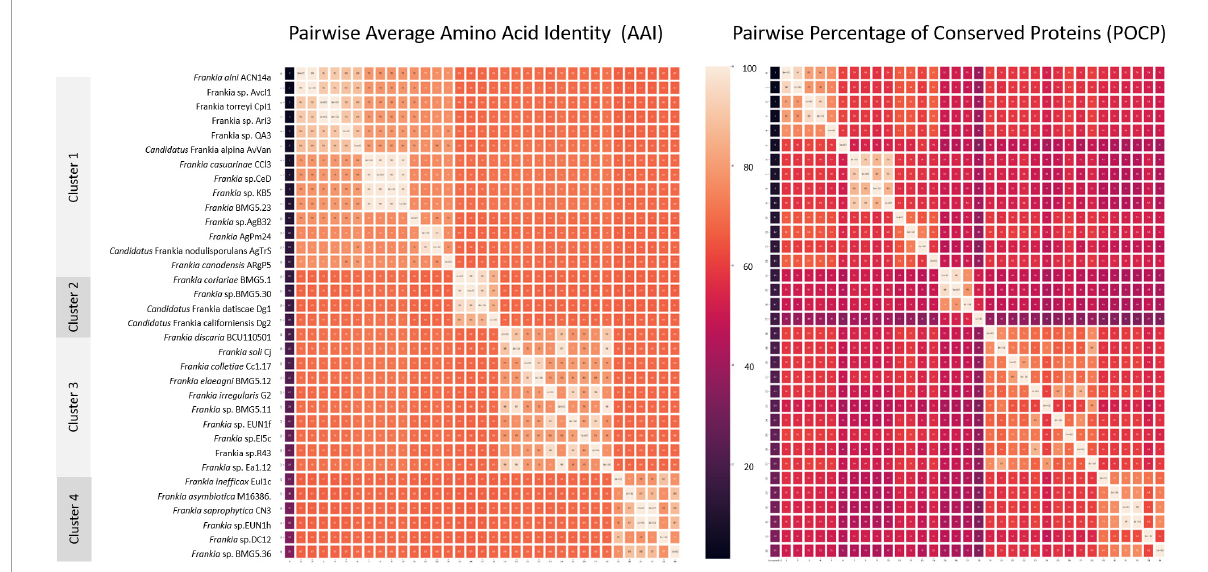
FIGURE4 Heat maps based on pairwise average amino acid identity (AAI) and percentage of conserved proteins (POCP) calculated values. Pairwise AAI was calculated with the EzAAI tool (v1.1) using default settings, with a minimum query coverage of 50% and a minimum identity of 40%. The pairwise POCP was calculated considering an E-value of < 1 × 10–5, > 40% sequence identity and > 50% of the query sequence.